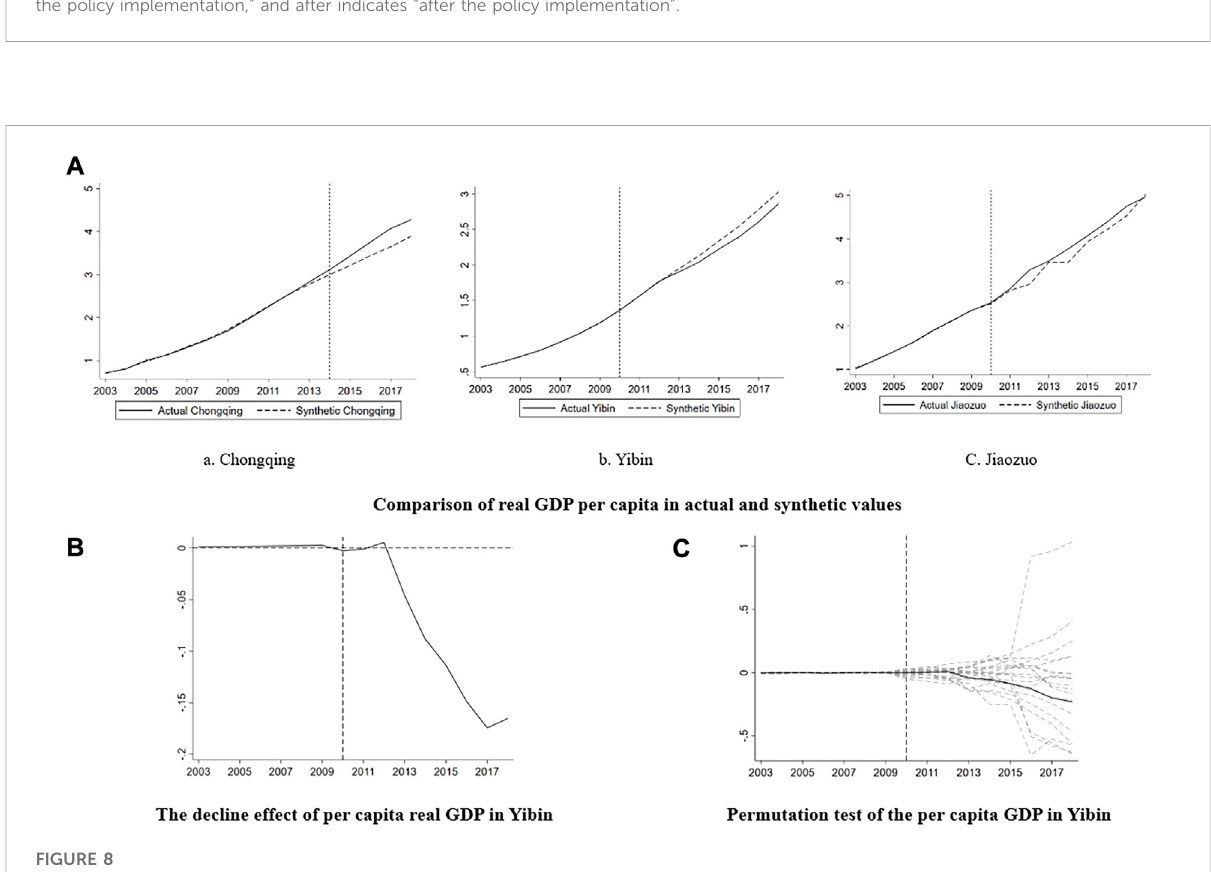
FIGURE 8 Synthetic control results of economic